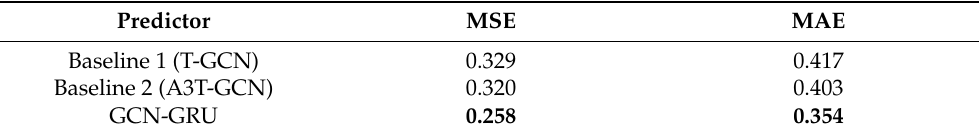
Table 3. MSE and MAE of crowd volume prediction models.